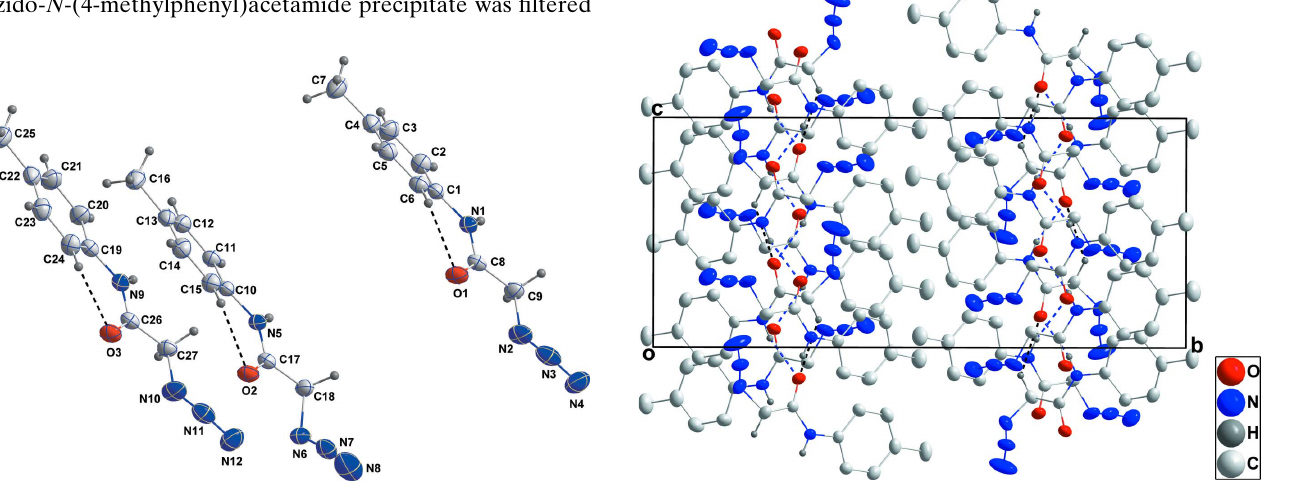
Figure 3 Packing viewed along the a -axis direction with N—H (cid:4)(cid:4)(cid:4) O and C—H (cid:4)(cid:4)(cid:4) O hydrogen bonds indicated, respectively, by blue and black dashed lines.